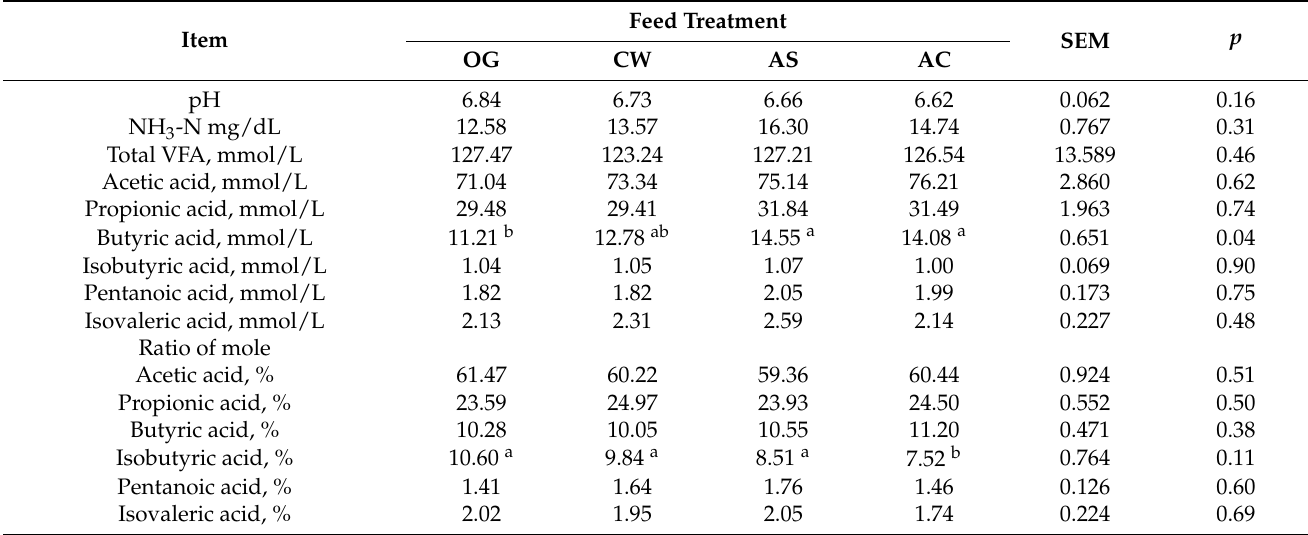
Table 6. Effects of total mixed diets with different forage type on 12 h rumen fermentation 3 .